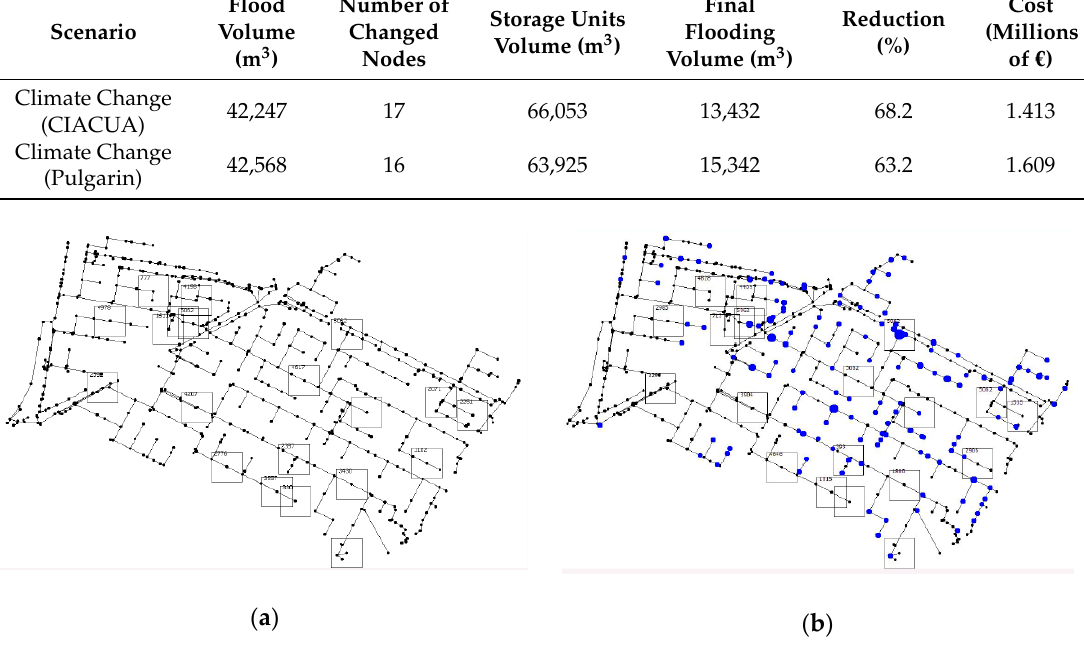
Figure 9. Results for the stormwater tank locations using OptSU. The black points are nodes of the system and the blue points represent floods. ( a ) Results considering the CIACUA approach for Climate Change. ( b ) Results considering the Pulgarín approach for Climate Change.